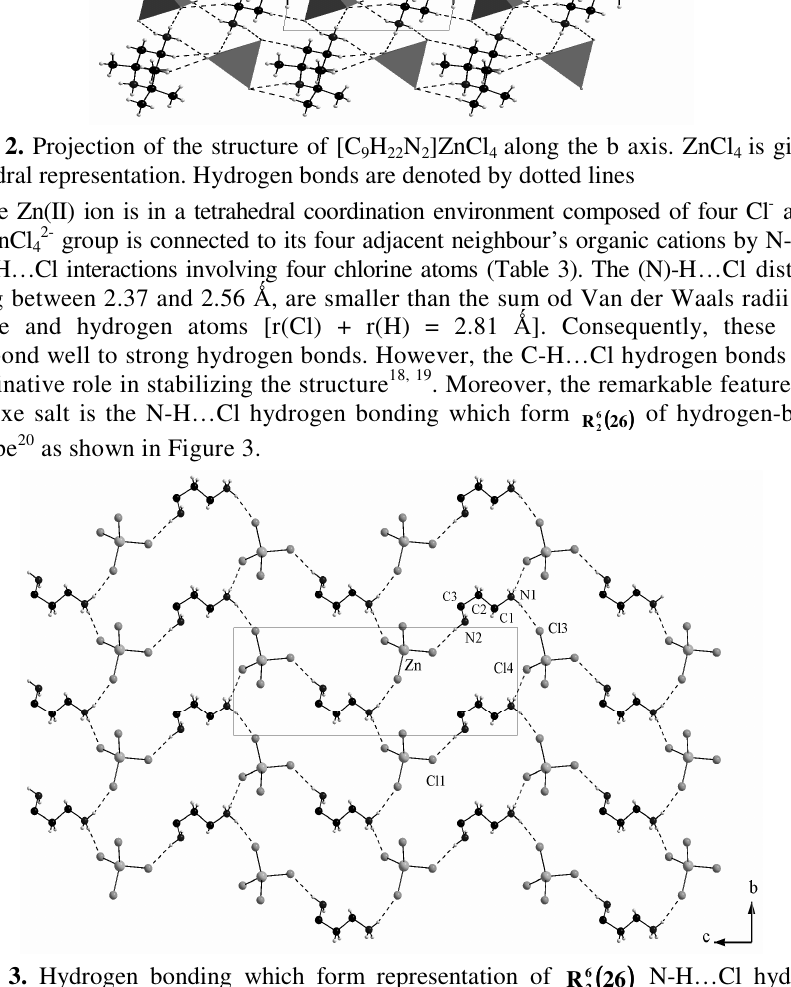
H N ]ZnCl 9 22 2